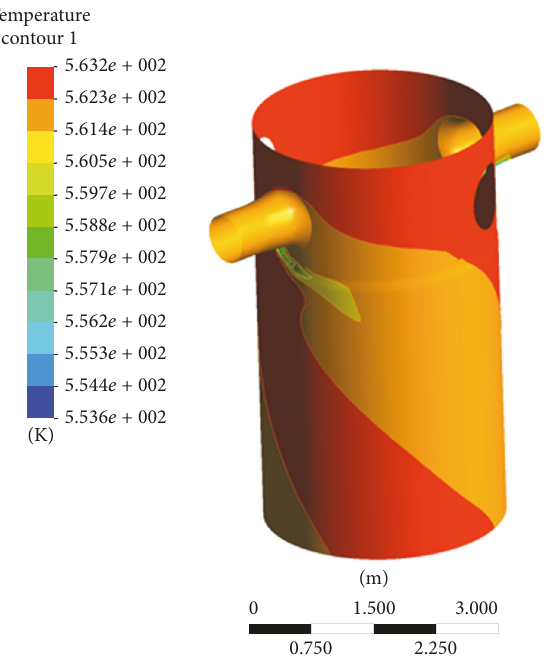
Figure 15: Temperature distribution of RPV wall at 110s.